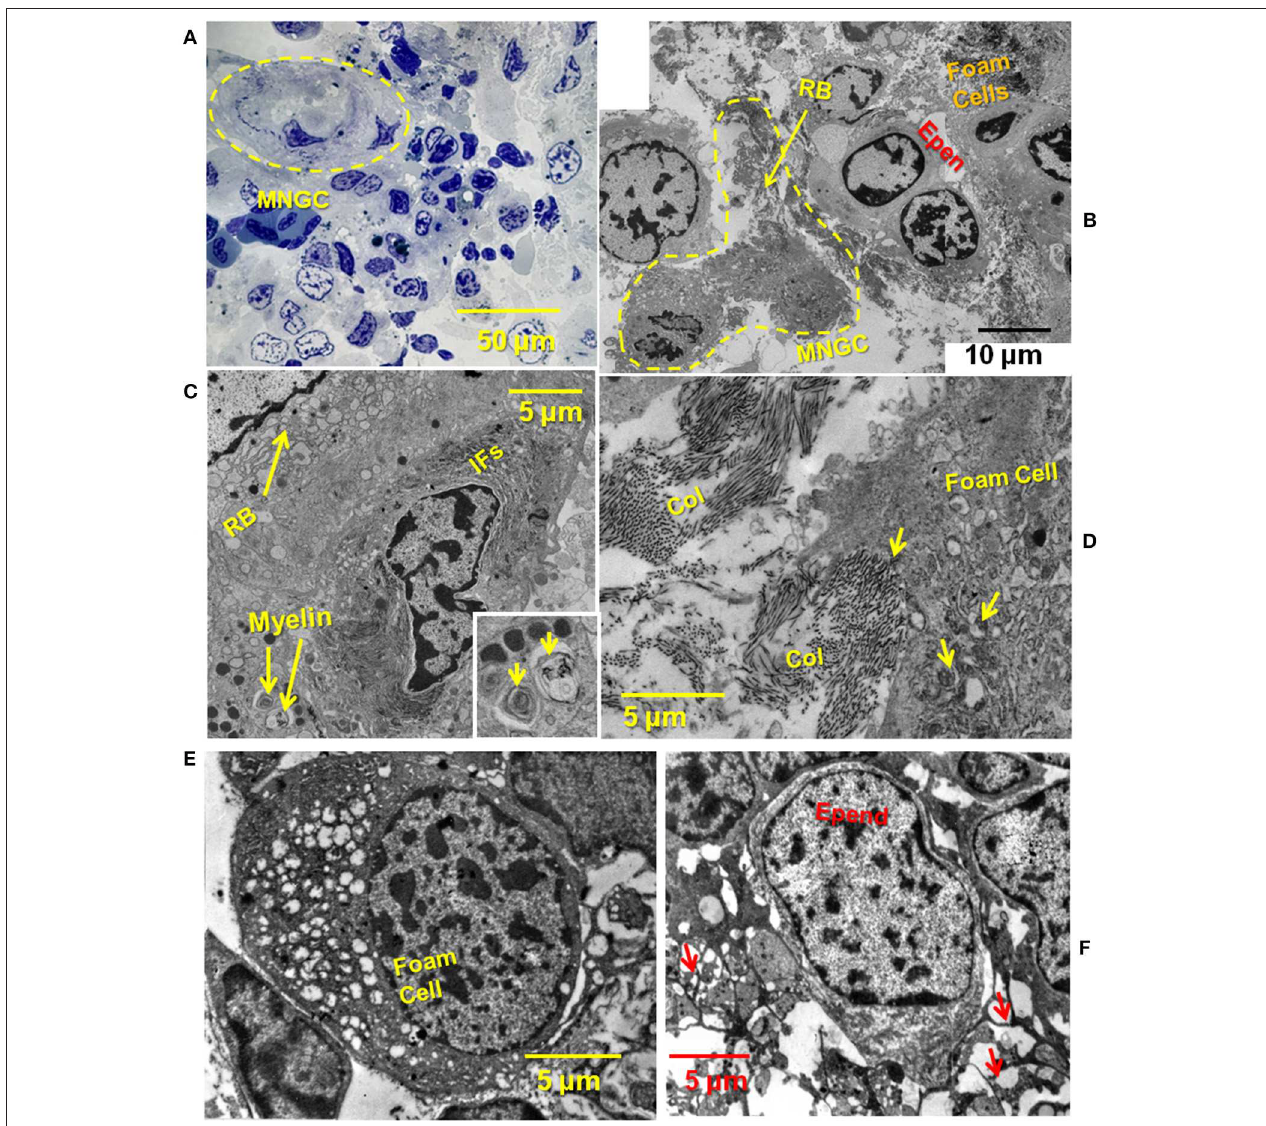
FIGURE 3 | TEM showing close relationship between MNGC, ECM, ependymal cells, and foam cells. (A) Thick section of plastic embedded 2-weeks spinal cord regenerate outgrowth stained with toluidine blue. Yellow dashed circle surrounds MNGC. (B) Thin section TEM of lesion site shown in (A) . A portion of the MNGC is circled in yellow (dashed line). Arrow indicates portion of the ruffled border. Foamy macrophages and ependymal cells are present. (C) A portion of the ruffled border, and perinuclear intermediate filaments are shown. Engulfed myelin fragments are present within the cytoplasm. Engulfed myelin enlarged in inset (arrows) (D) Foamy macrophage engulfing fibrillar collagen within the lesion site. Arrows show intracytoplasmic collagen. (E) Deeper within the lesion site a foamy macrophage is present among ependymal and meningeal cells. (F) Deeper within the lesion site an ependymal cells show a network of processes (arrows). MNGC, multinucleated giant cells; RB, ruffled border; RBC, red blood cell; Epen, ependymal cells; Ifs, intermediate filaments; Col, collagen; Mening, meningeal cell; macr, macrophage; Nucl, nucleus. Magnification bar is shown in the lower portion of each